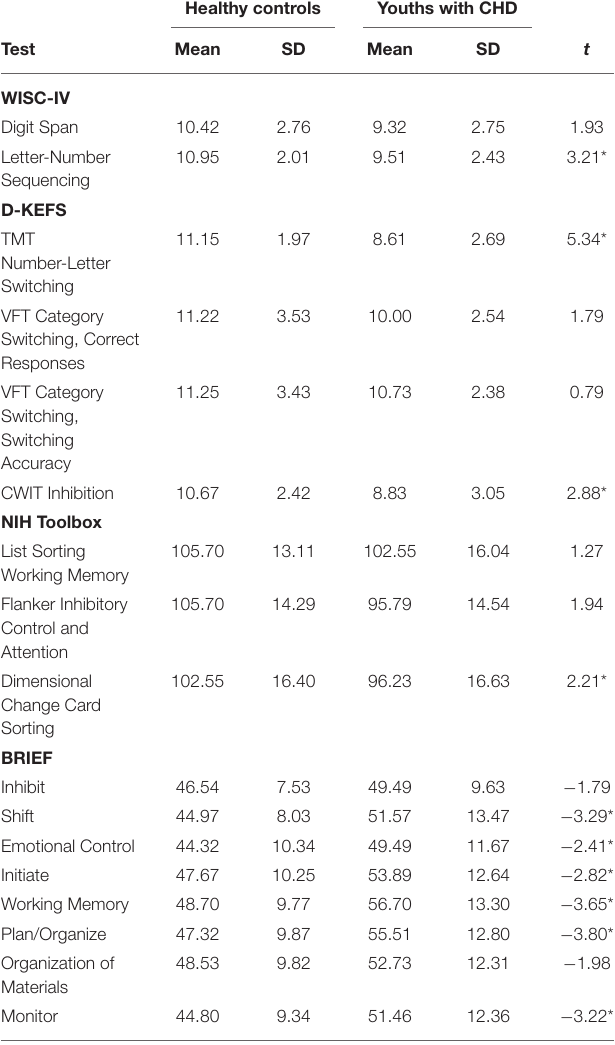
TABLE 3 | Executive functioning differences between youth with CHD and healthy controls. Healthy controls Youths with